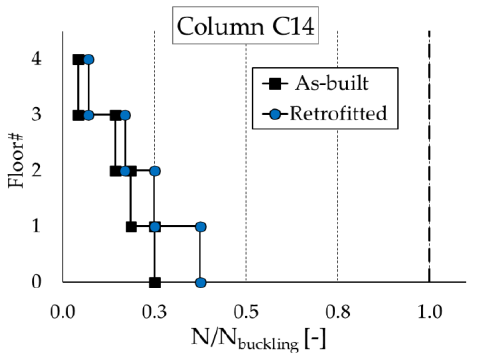
Figure 21. Buckling check of column C14 (Figure 12b) of the steel MRF.